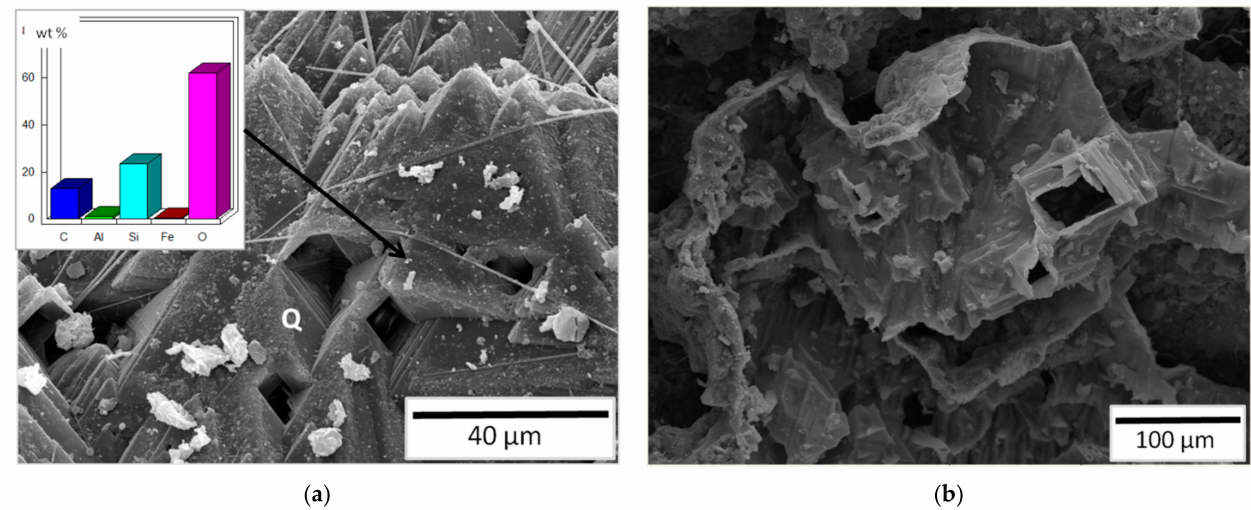
Figure 9. SEM images: the quartz surface of biofilm ( a ), negative casts of biofilms on the quartz surface ( b ). Q: quartz.